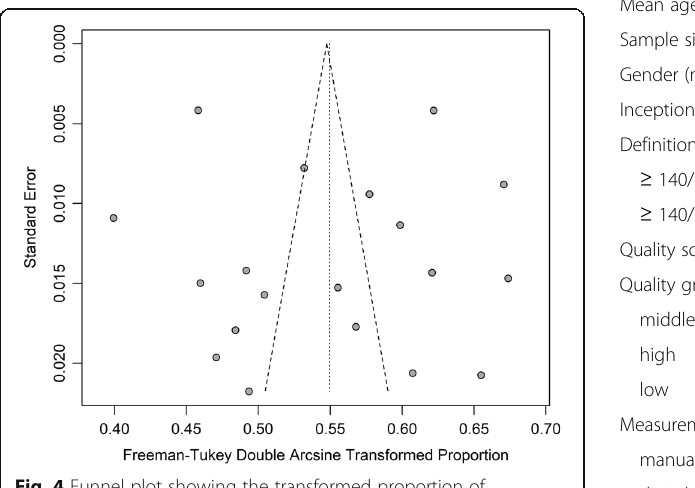
Fig. 4 Funnel plot showing the transformed proportion of hypertension in each study by the standard error